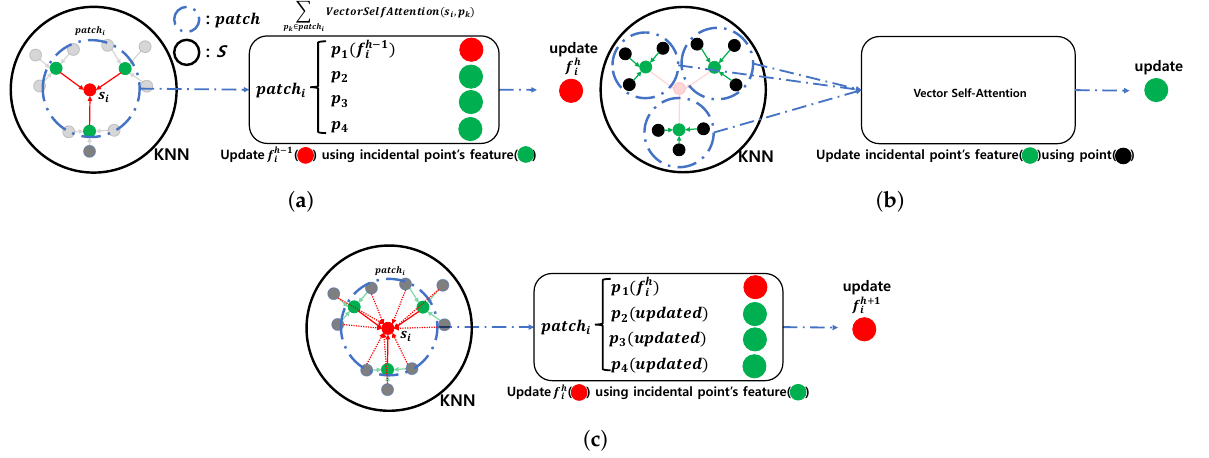
Figure 3. Illustration of KNN and VSA in PT. ( a ) h th Point Transformer layer with s i . ( b ) h th Point Transformer layer with incidental points. ( c ) ( h + 1 ) th Point Transformer layer with s i